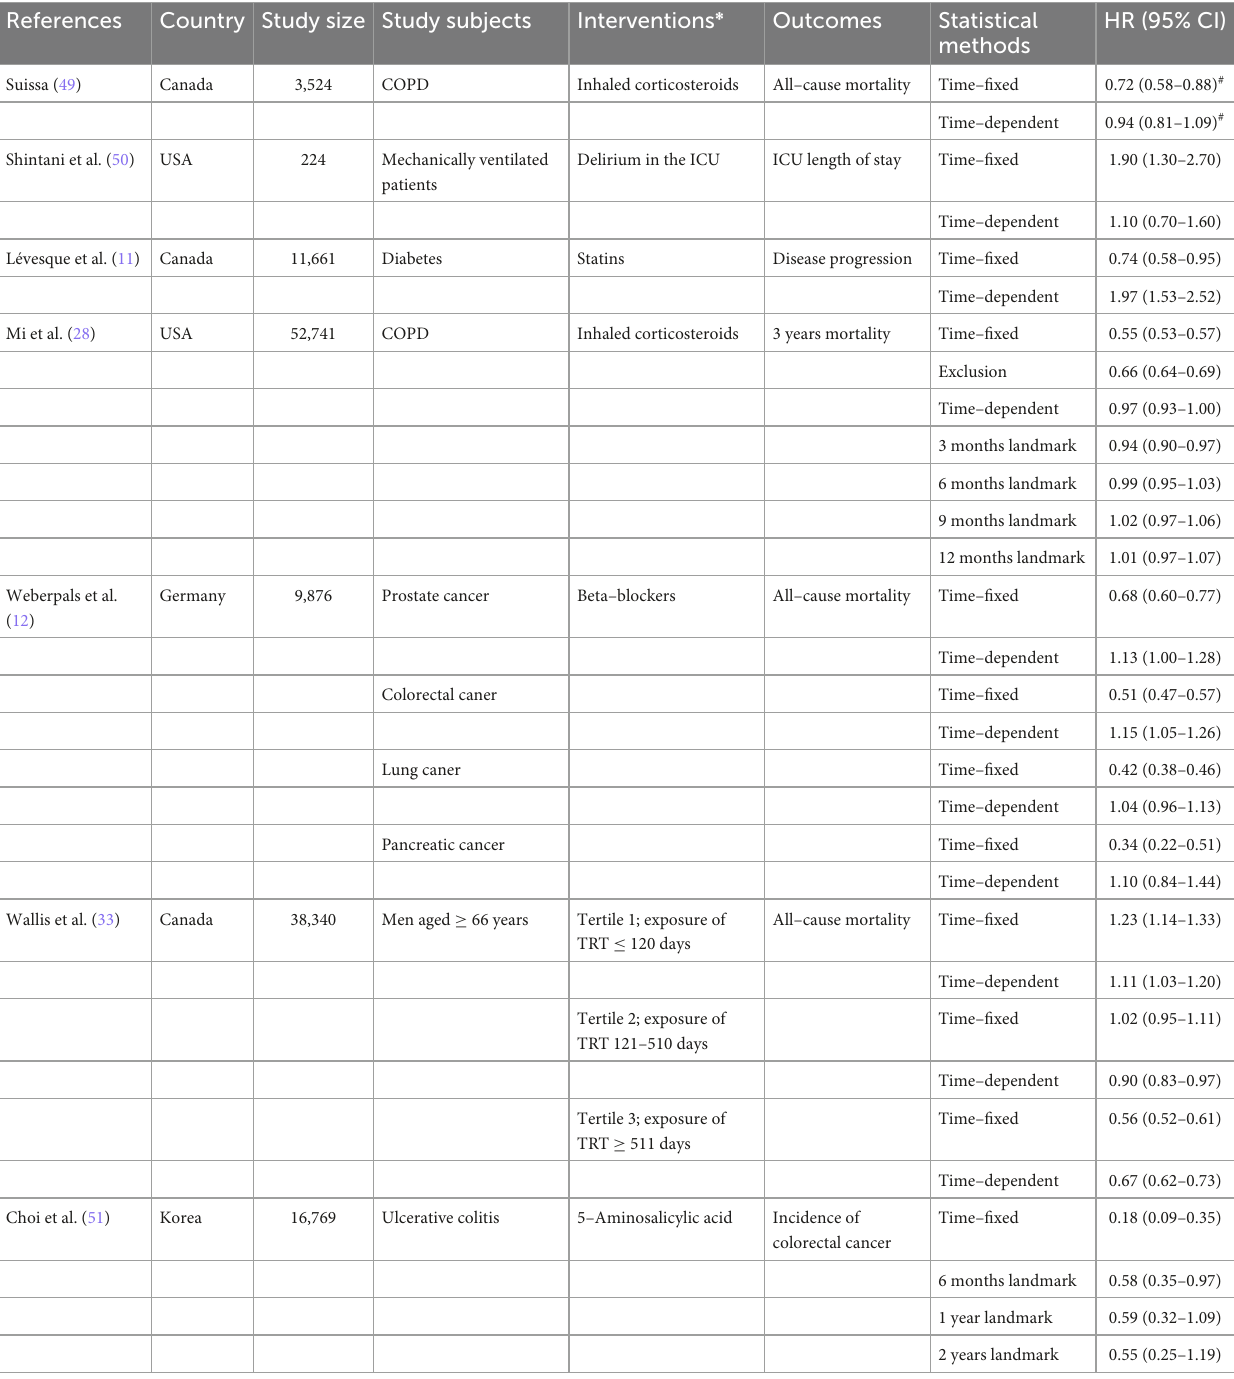
TABLE 3 Description of seven observational studies of the effects of interventions on study outcomes using various statistical methods for handling immortal time bias